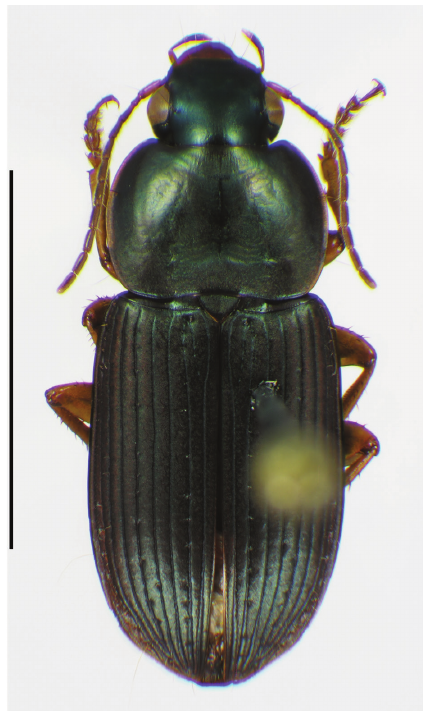
Figure 22. Habitus digital image of Selenophorus seriatoporus species group, dorsal aspect, S. spinosus sp. n. Scale bar 5 mm.